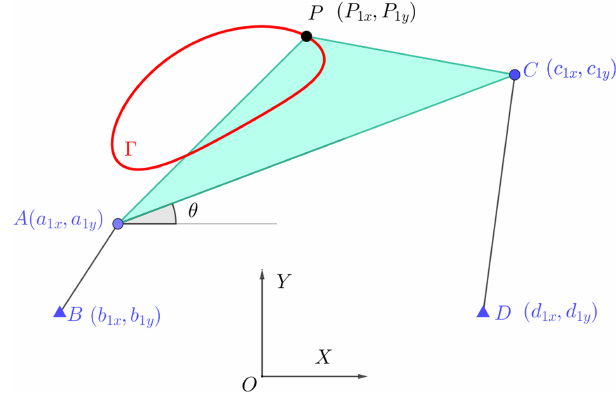
Figure 2. A typical planar four-bar linkage. and P . B ( b 1 x ,b 1 y ) and D ( d 1 x ,d 1 y ) are the coordinates of the fixed pivots. Herein, A ( a 1 x ,a 1 y ), B ( b 1 x ,b 1 y ), C ( c 1 x ,c 1 y ), and D ( d 1 x ,d 1 y ) are the coordinates described in O – XY . The are represented by A ( a ix ,a iy ) and C ( c ix ,c iy ). θ is the